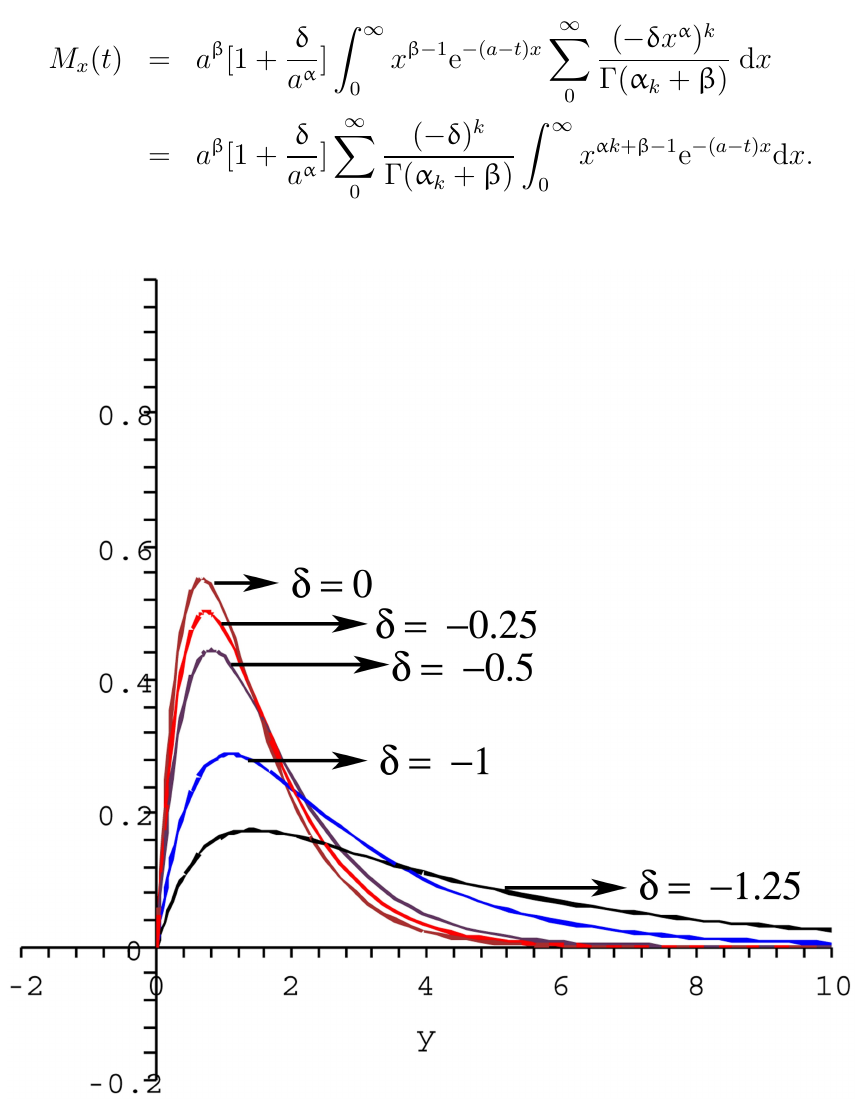
Figure 1. For a = 1 . 5 , β = 2 and δ < 0